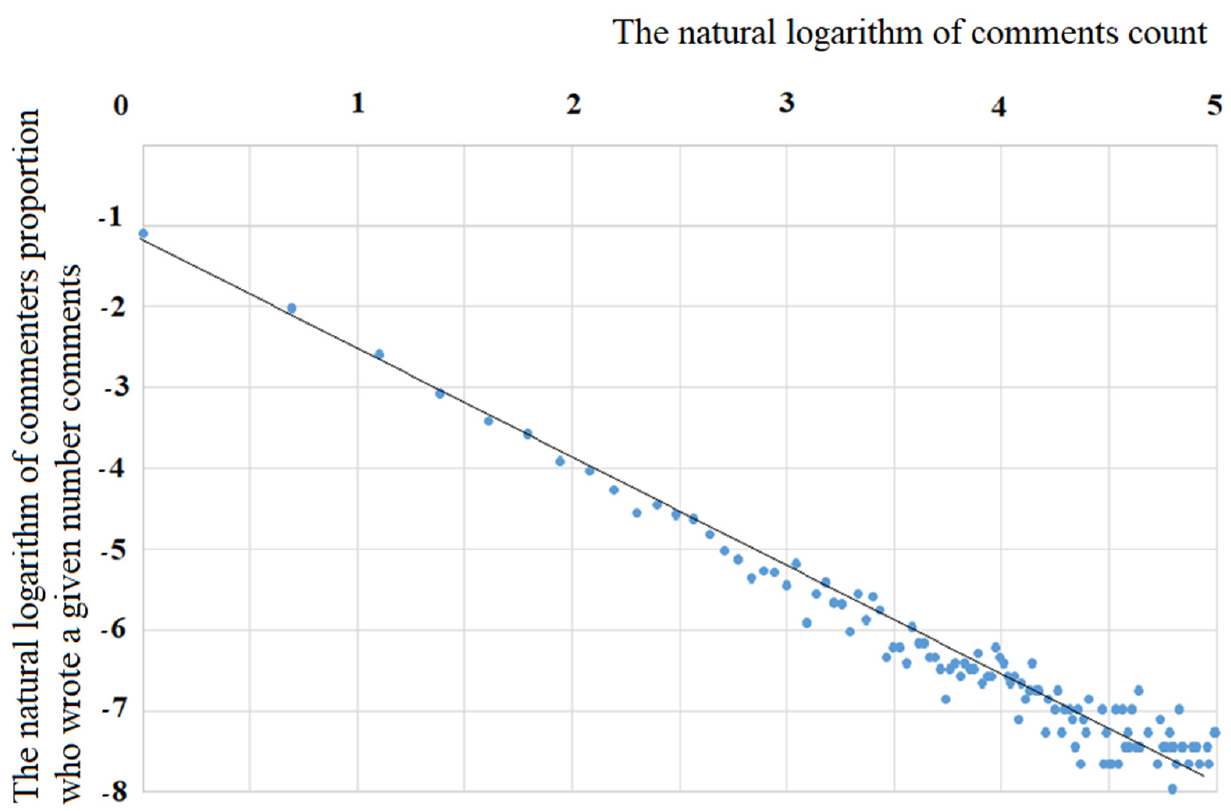
Figure 5. Linearization of the observed data for power distribution after cleaning unscrupulous us- ers.